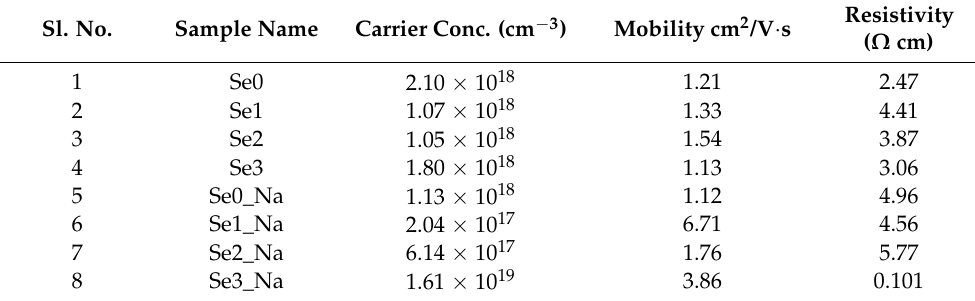
Table 2. Electrical properties of CZTS thin films with and without Na layer. Sl.